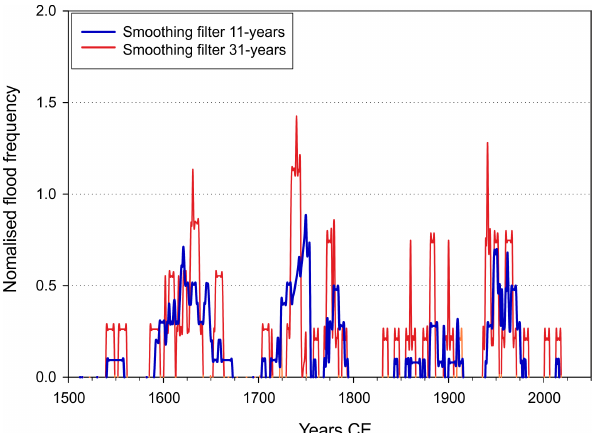
Figure 3. Normalised flood frequency distribution of the docu- mented number of floods (only catastrophic + extraordinary cate- gories) of the Duero River in Zamora using moving average, tak- ing 11-year and 31-year data intervals. The anomalies for 1500– 1880CE were estimated from documentary records and after 1980 include gauged floods (staff gauge and continuous gauge) with dis- charge higher than 1900m 3 s − 1